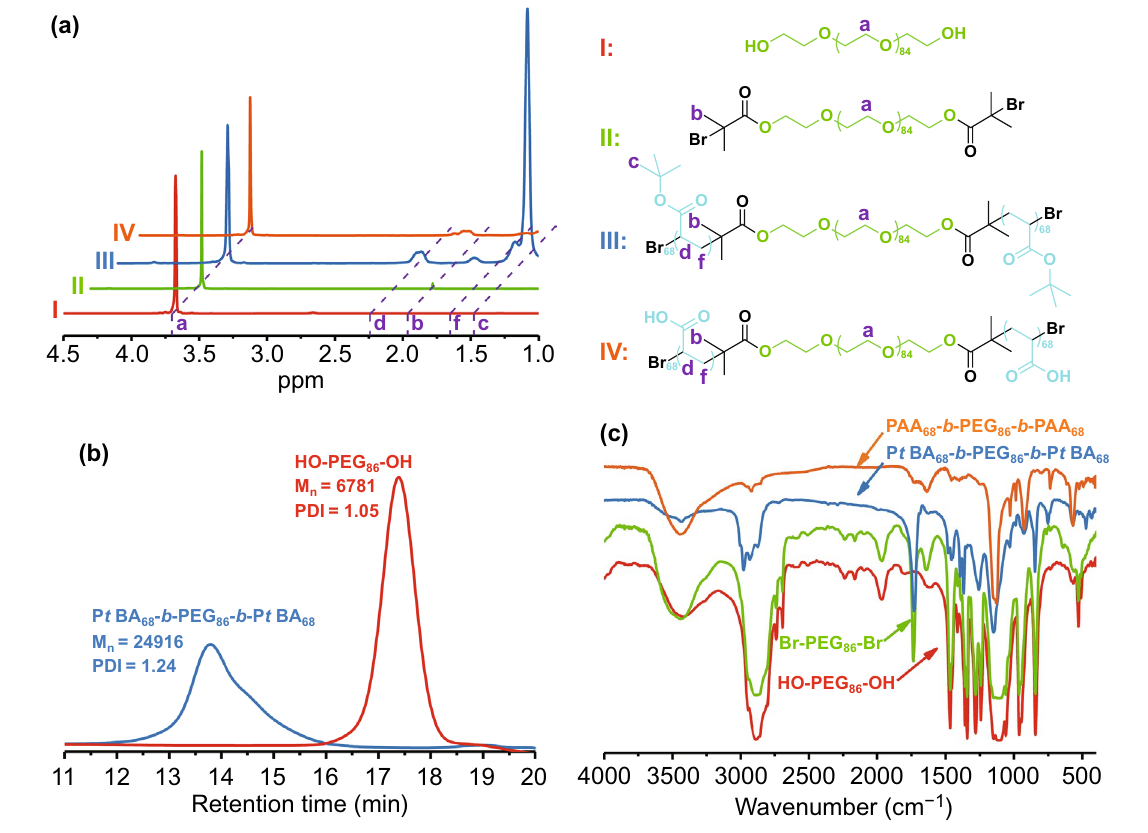
Fig. 1 a 1 H NMR spectra of HO–PEG 86 –OH (I), Br–PEG 86 –Br (II), P t BA 68 – b –PEG 86 – b –P t BA 68 (III), and PAA 68 – b –PEG 86 – b –PAA 68